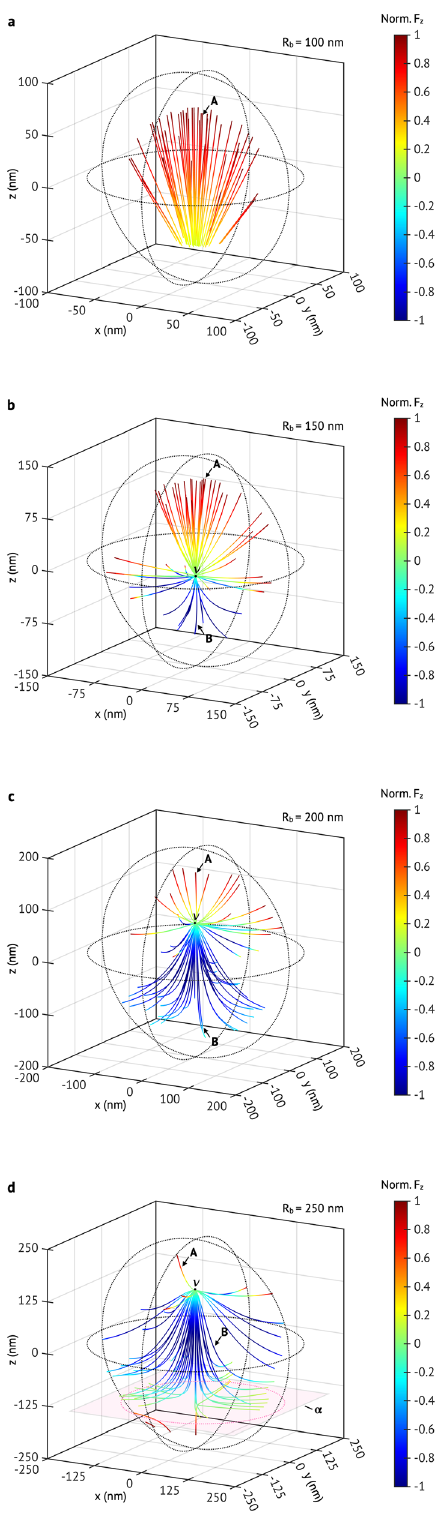
Figure 3: The vector field lines of optical force on a TiN NP in various sizes of nanobubbles: (a) R b = 100 nm (b) R b = 150 nm, (c) R b = 200 nm (d) R b = 250 nm. In (a) to (d), R n = 35 nm, and λ = 1050 nm; the color of each vector fi eld line corresponds to